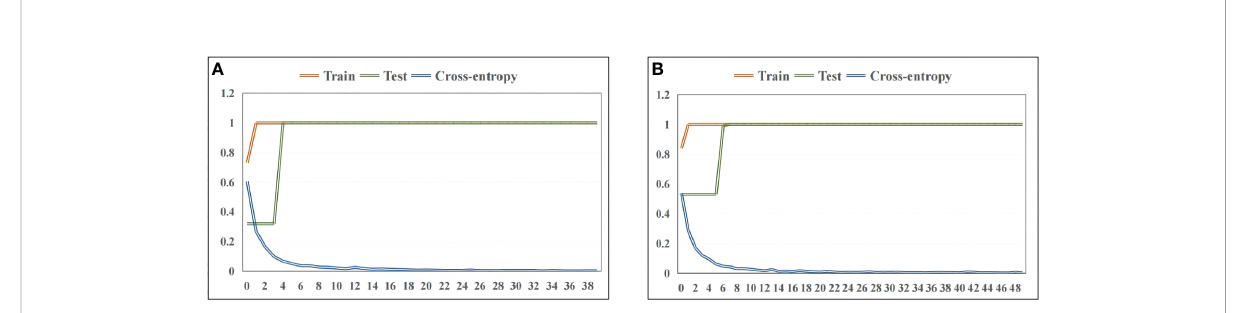
FIGURE 4 The accuracy curve and cross-entropy cost function of ResNet models based on wild and cultivated W. cocos in different parts: (A) Poria and (B) Poriae